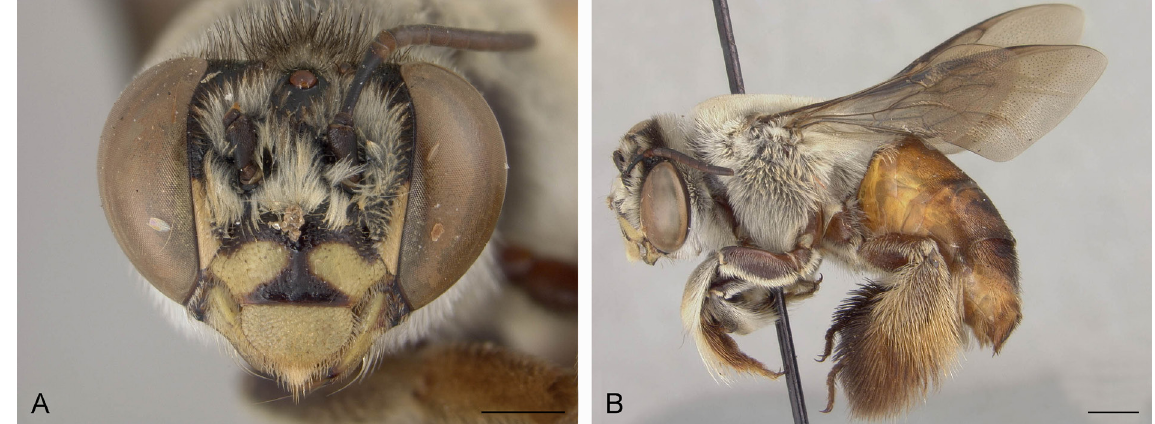
Fig. 11. Centris merrillae Cockerell, 1919, holotype, ♀ (NMNH; USNM ENT 00534204). A . Frontal view. B . Habitus, lateral view. Scale bars: A = 1 mm; B = 2 mm.